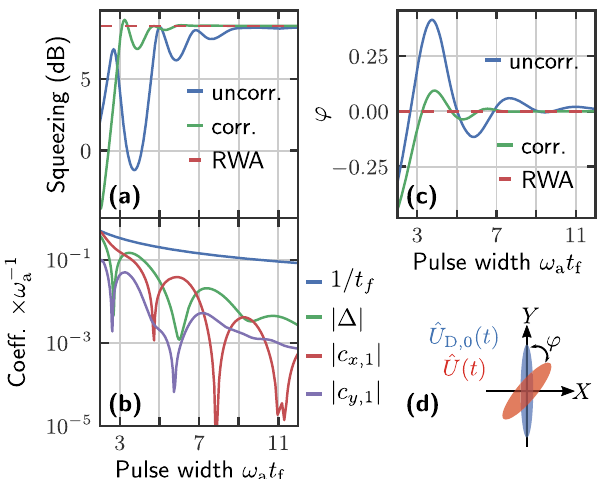
Fig. 3 Fast generation of squeezing with a parametrically driven cavity. a Squeezing as a function of the total evolution time. The red trace corresponds to the ideal case where the fast oscillating terms have been neglected. The blue trace shows the squeezing when the fast oscillating terms are present and no correction is used. The green trace shows the squeezing with the modi fi ed Hamiltonian (up to sixth order). b Coef fi cients of the correction Hamiltonian as a function the f c ð n Þ x ; 1 ; c ð n Þ y ; 1 ; Δ ð n Þ g . c Angle in phase space where the squeezing n ¼ 1 is maximal as a function of gate time. In the ideal case, Δ φ = 0. d The squeezed states generated by the ideal Hamiltonian ^ H C ; 0 ð t Þ (blue) and the total Hamiltonian ^ H C ; R ð t Þ (red) in the phase space. The state generated by the total Hamiltonian is usually less squeezed and displays maximum squeezing along a different